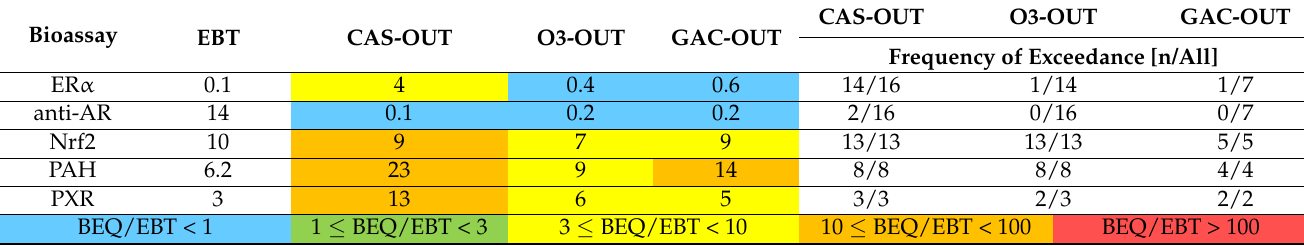
Table 2. n-fold EBT-exceedance of the median BEQ for all sampling campaigns. The color code refers to the degree of exceedance.